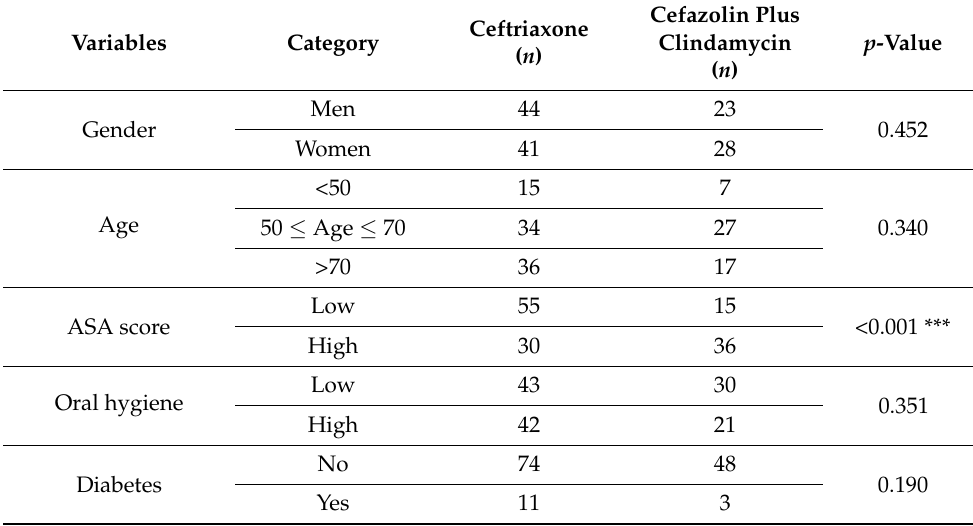
Table 5. A Demographic study is performed by using the chi-square test to investigate the frequencies related to each variable. * Significance at 0.05; ** significance at 0.01; *** significance at